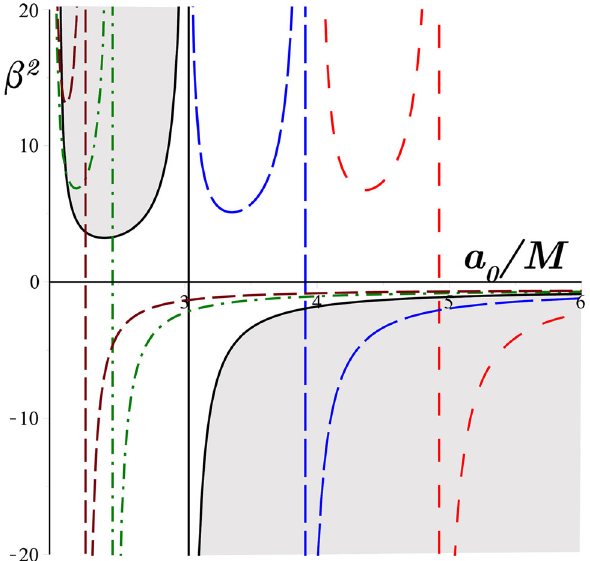
Fig. 5 The plots of β 2 versus x 0 = a 0 for an S–S ∗ ATSW with γ = 0 M Fig. 6 The plots of β 2 versus x 0 are given for an S–S ∗ ATSW when and (from left to right i.e., brown-dash, green-dash dot, black-solid, γ = − 1 /π M 2 x 2 while a (cid:18) = − 1, b (cid:18) = 0, c (cid:18) = 1, and d (cid:18) = 2. blue-long dash and red-space dash) (cid:18) = − 1 . 0 , − 0 . 5 , 0 . 0 , 0 . 5 and 1 . 0 . 0 Although the generic shape of the plots has shown no drastic change The stable regions for (cid:18) = 0 . 0 are shaded. For the other values of (cid:18) the compared with the case of a barotropic EoS, the shifts in the range of stable regions are the same as (cid:18) = 0 . 0 but are not coloured β 2 somehow state that the stability has decreased. A sign S implies the stable